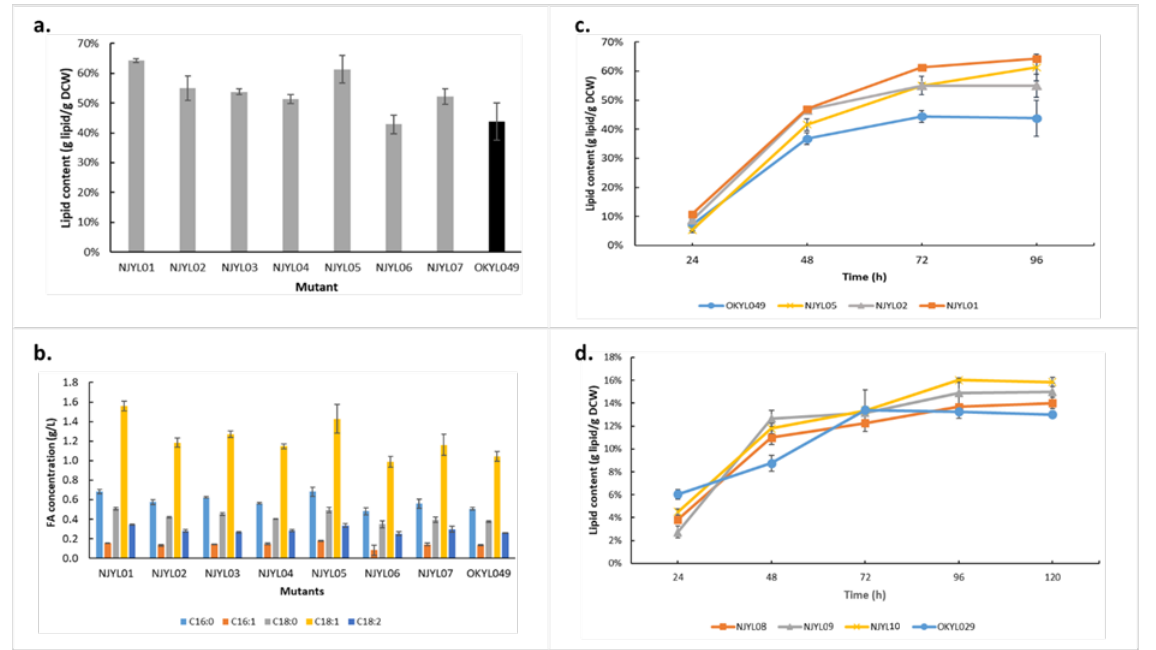
Figure 4. Lipid phenotype of Y. lipolytica after genetic engineering of selected targets. Lipid content ( a ) and fatty-acid composition ( b ) of 7 mutants cultivated for 96 h in nitrogen-limited shaken flasks in comparison to Y. lipolytica OKYL049. ( c ) Time-course lipid content analysis of the three most promising mutants with OKYL049 as control. ( d ) Time-course lipid content analysis of mutants with the same genetic targets as in ( c ), but now implemented in the OKYL029 background. Data are presented as the average of three independent experiments, Error bars represent means ± standard deviation.